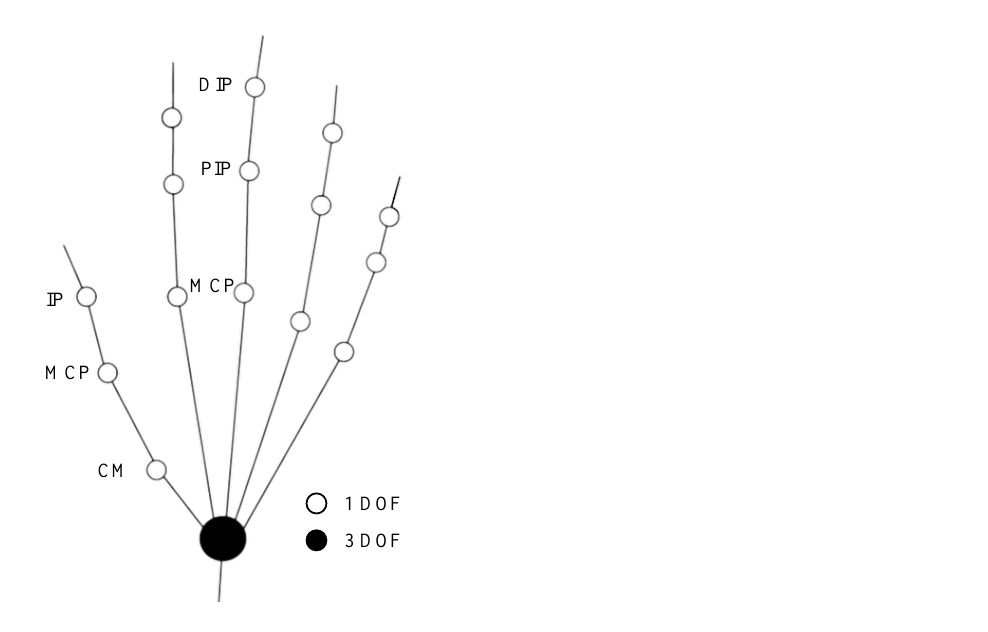
Figure 2. Schematic diagram of motion structure of hand connecting rod.